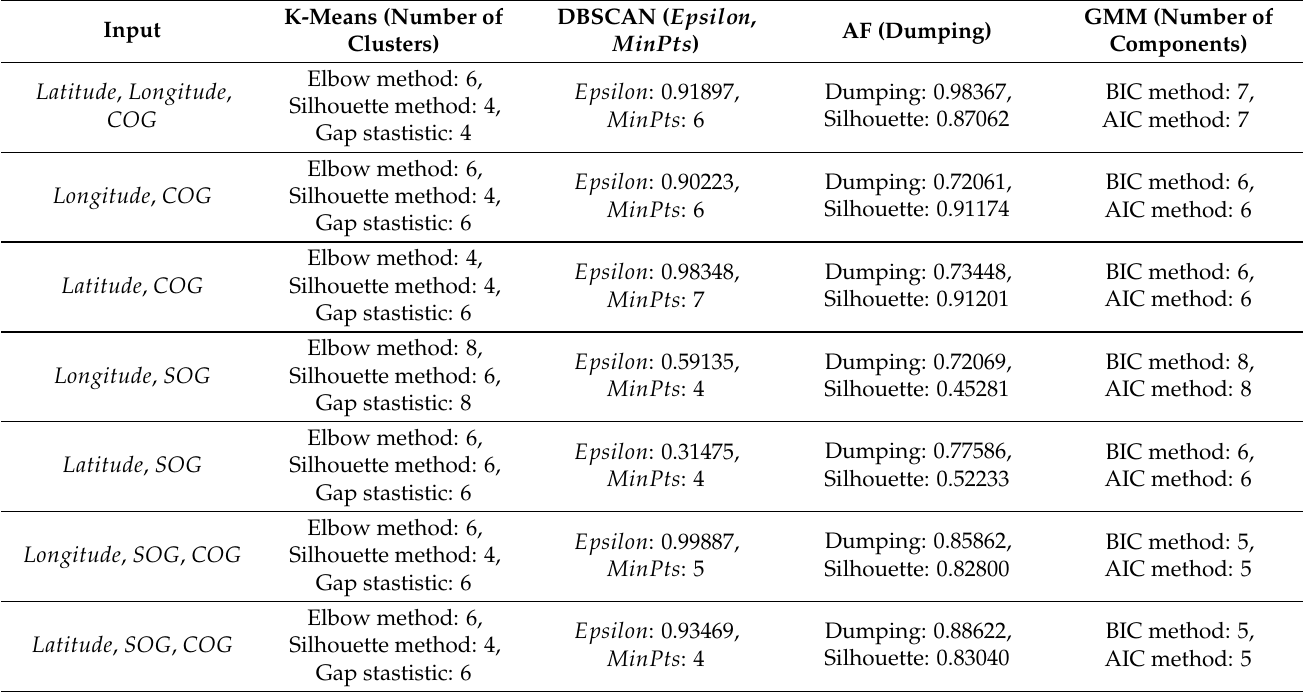
Table 4. Results of parameters selection process of clustering algorithms based on different inputs (two-dimensional and